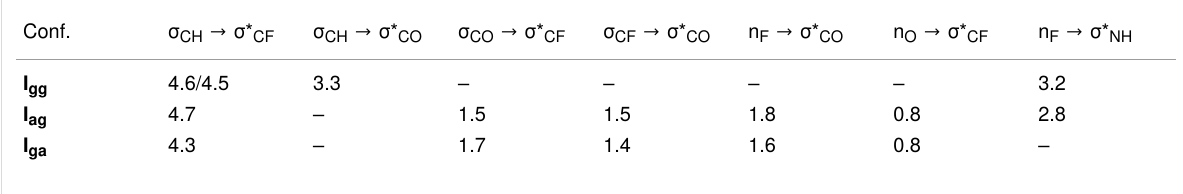
Table 1: Second order perturbation energy E (2) of the main hyperconjugation interactions (in kcal mol –1 ) computed at the ω B97X-D/6-311G(d,p) level of theory. Conf.